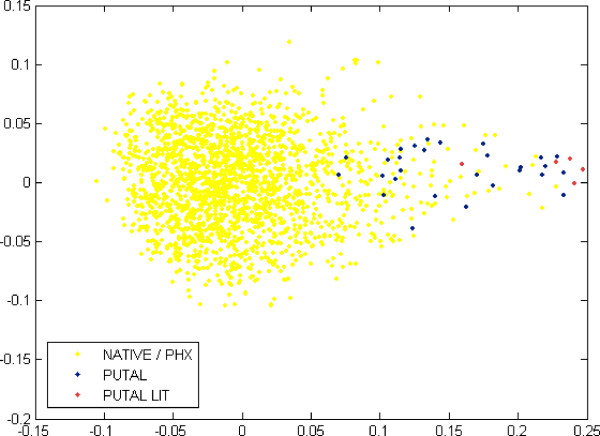
Kernel-based scatter plot visualization of SIGI-HMM predictions for T. thermophilus. Blue points (PUTAL) represent pA genes as predicted by SIGI-HMM, red points (PUTAL LIT) indicate predicted pA genes with additional evidence from the current literature as described in the text. Yellow points (NATIVE / PHX) refer to genes which are predicted to be native or highly expressed.